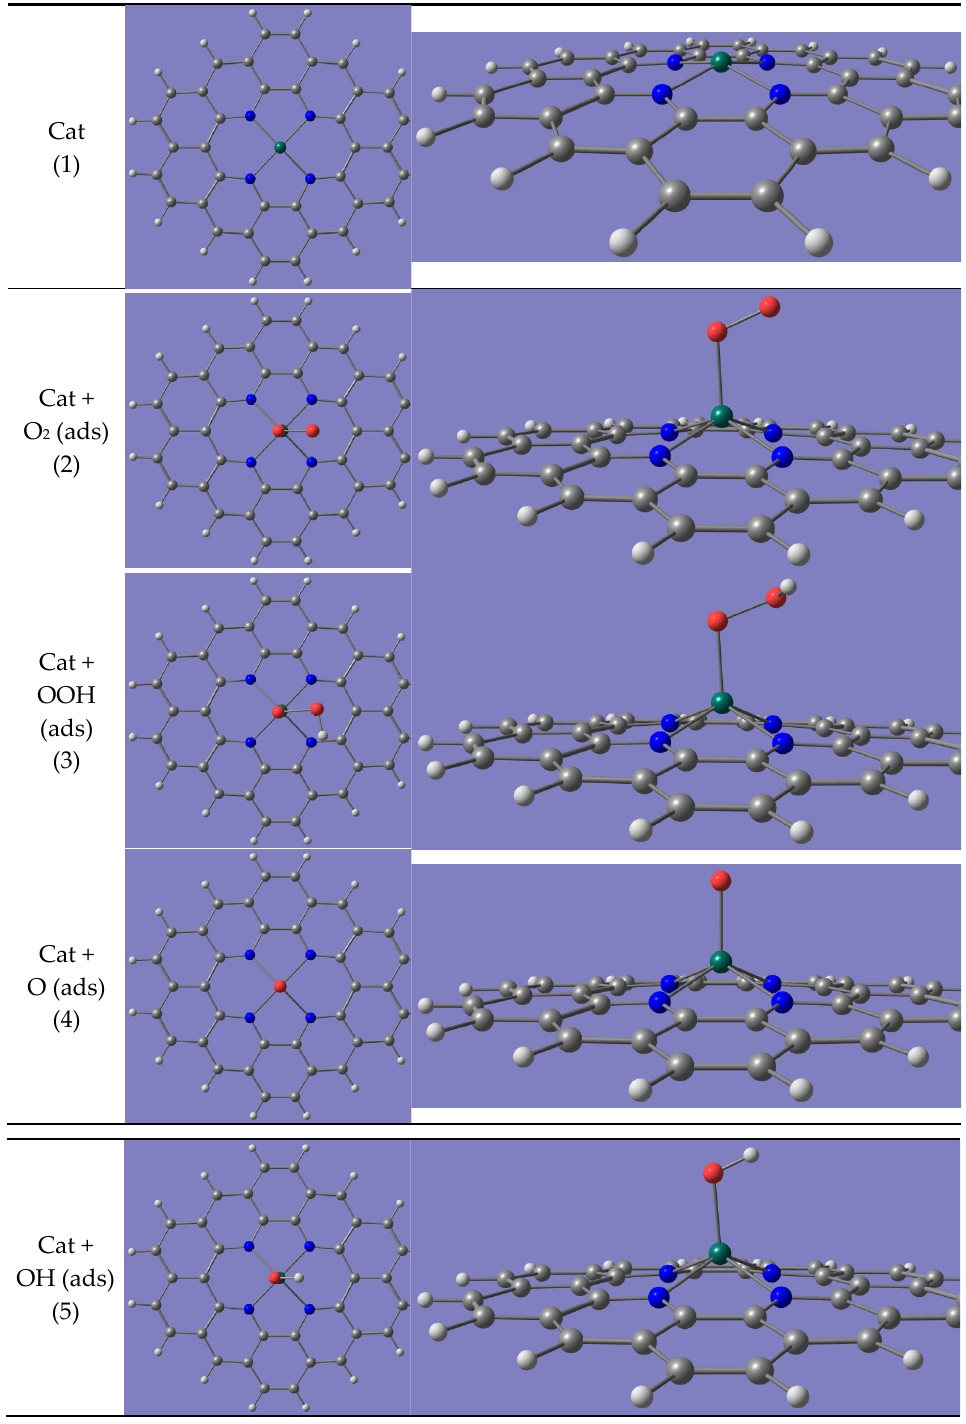
Figure 1. Model reaction of oxygen reduction on a catalyst containing zinc.